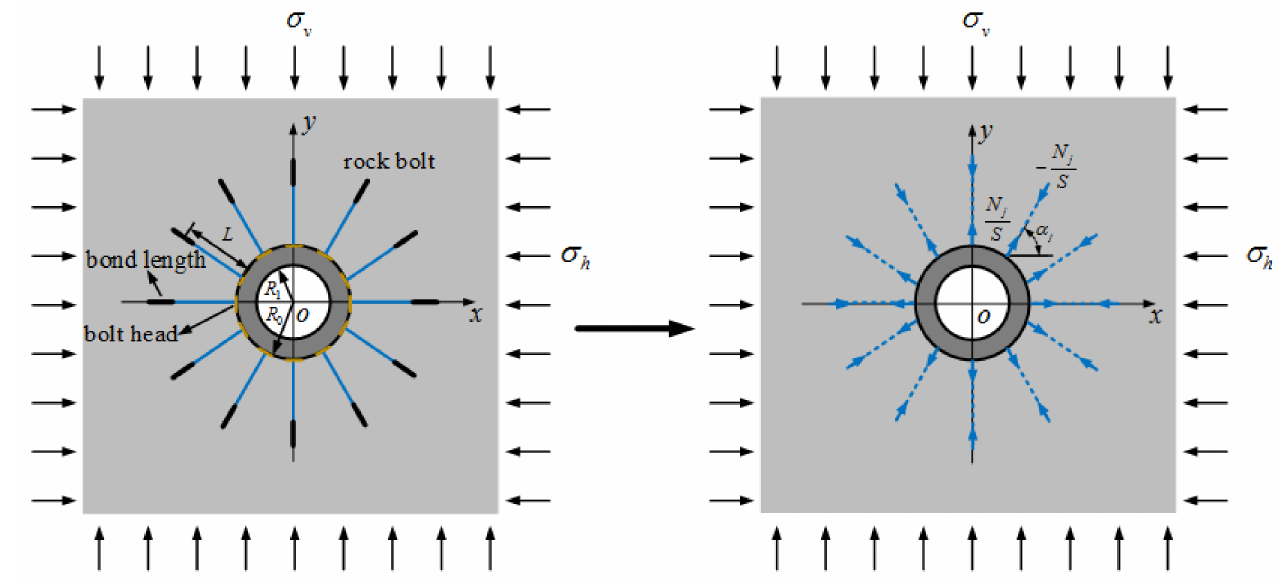
Figure 1. The equivalent action of point-anchored rock